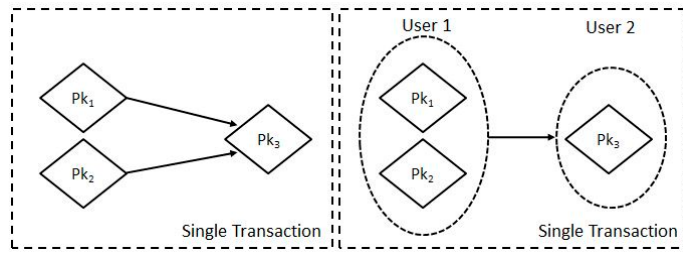
Figure 3. Forming the User Network.